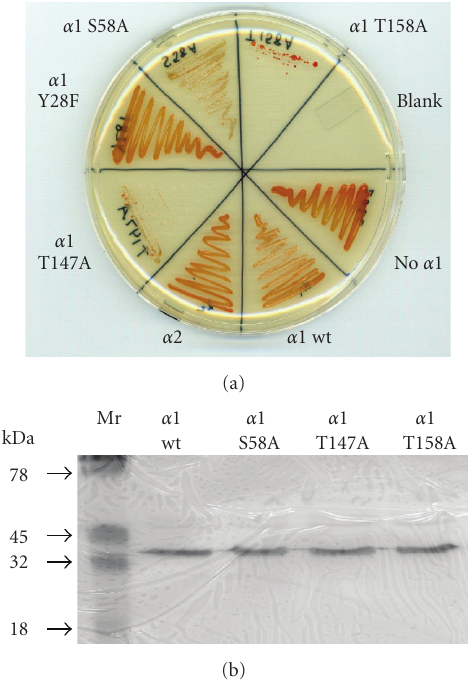
Figure 2: Analysis of an H. volcanii psmA ( α 1) knockout expressing wild type and variant α -type proteasomal genes in trans . (a) Growth and pigmentation of an H. volcanii psmA mutant (GZ130) were influenced by expression of α 1 variant proteins on ATCC novobiocin plates. Synthesis of α 1 Thr147Ala and α 1 Thr158Ala inhibited growth of the psmA mutant, while α 1 Ser58Ala and α 1 Thr147Ala altered pigmentation. (b) No significant di ff erence in α 1 protein levels were detected in the H. volcanii psmA mutant synthesizing the wild type and variant α 1 proteins from genes provided in trans . The α -type proteins encoded by the genes expressed in trans are indicated with the following